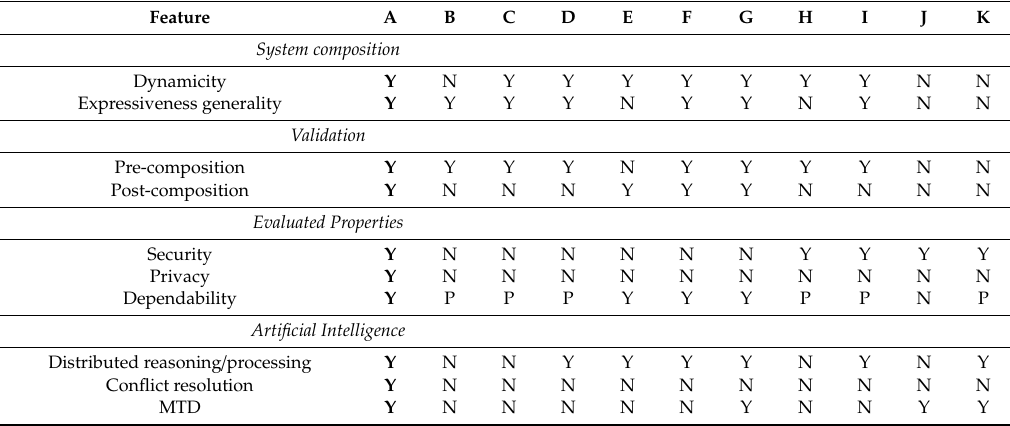
Table 1. System composition and security validation features: (A) CompoSecReasoner [ this paper